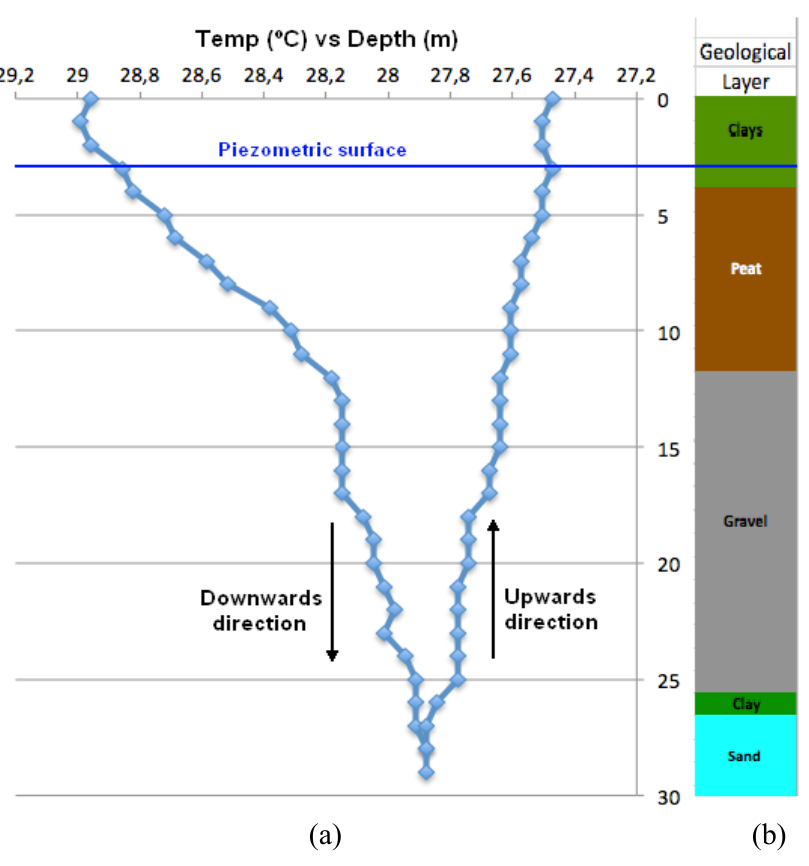
Figure 8. Thermal data as a function of borehole deep ( a ) and comparison with geological subsurface structure ( b